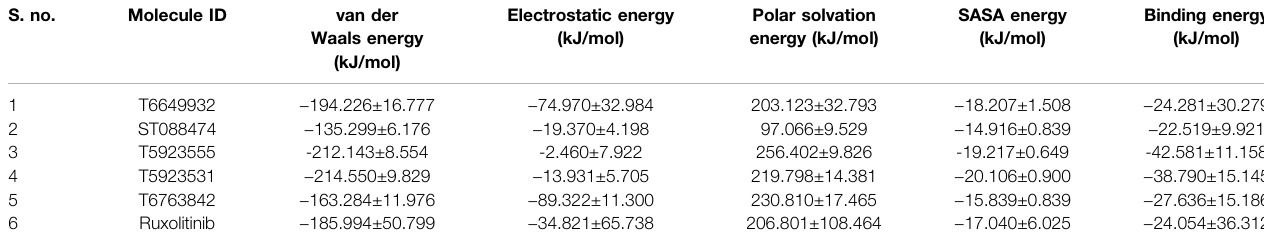
TABLE 12 | MM-PBSA results obtained from the molecular dynamics trajectory for the selected JAK1 lead compounds and the drug. S. no.